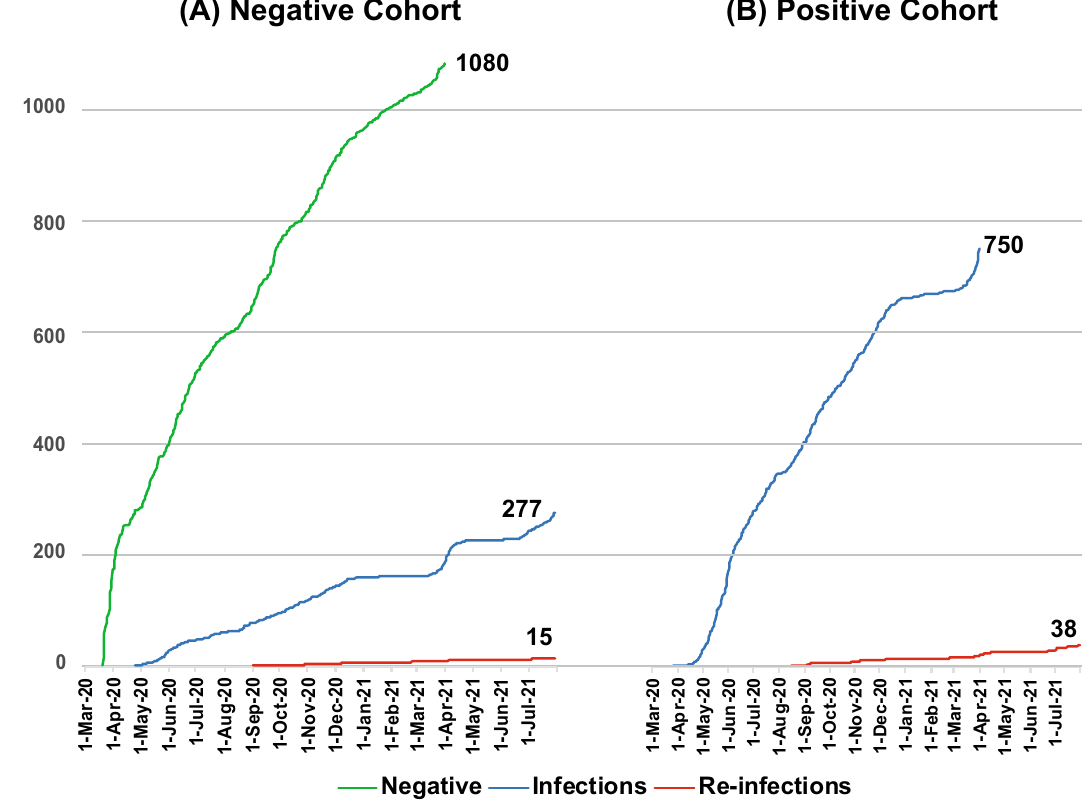
Figure 2. Cumulative number of cases in Y-axis from ( A ) negative cohort and ( B ) positive cohort and X-axis indicate timeline (date). The green line indicates a cumulative number of negative cohort enrolment; the blue line indicates a cumulative incidence of infection (first infection in negative cohort and enrollment in the positive cohort), and the red line indicates a cumulative number of